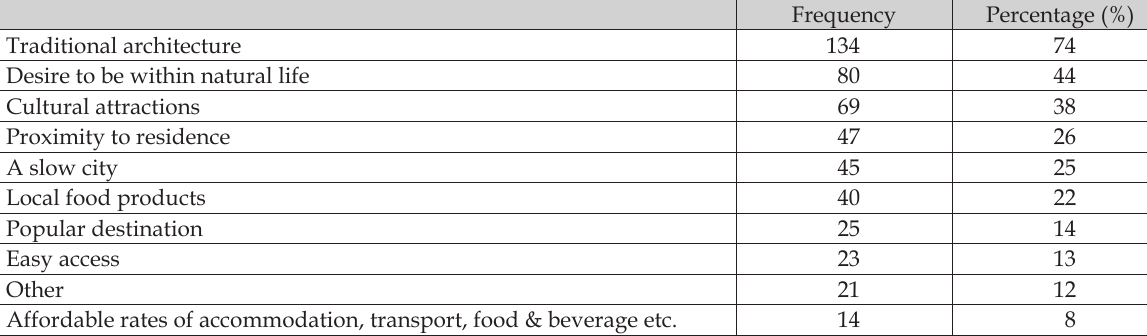
Table 1. Factors affecting the choice of Teraklı as a preferred tourist